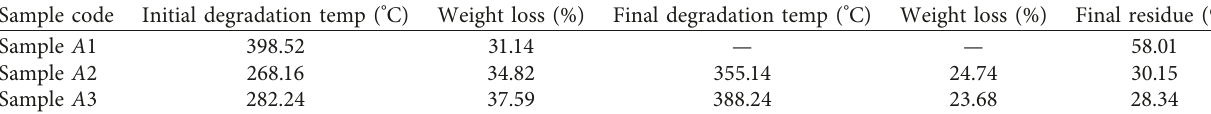
Figure 7: Morphology of polyester/HSTFs composite after tensile Table 3: Thermal stability of the prepared samples.